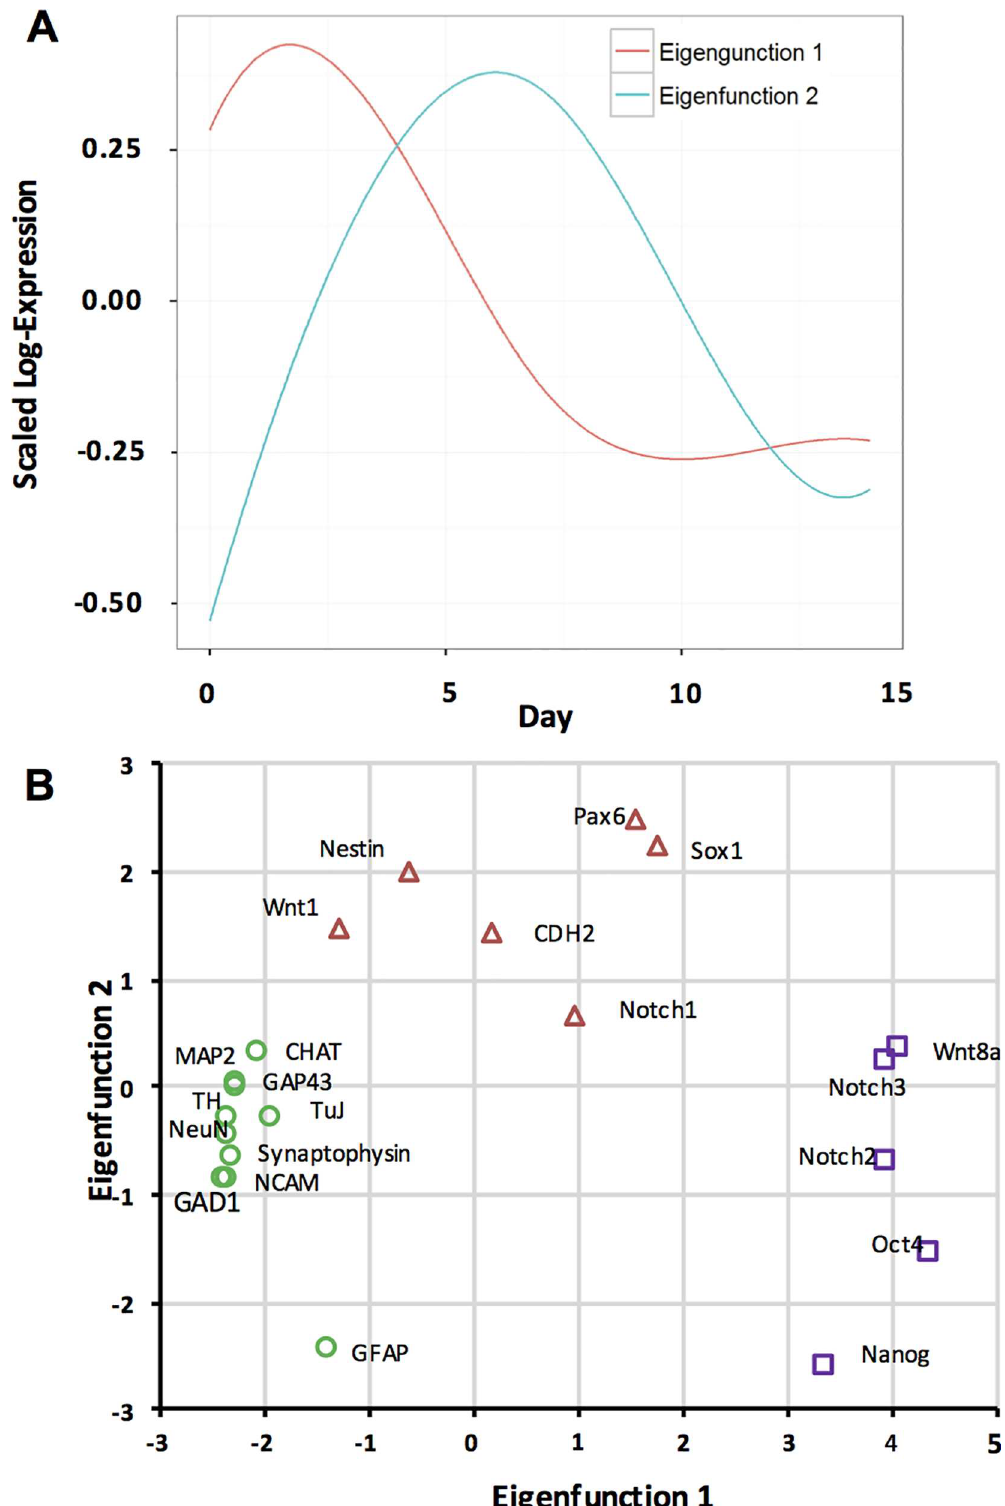
Fig 3. Functional principal component analysis of gene expression. (A) Eigenfunctions (EF) of gene expressionare shown over time. The trajectory of each gene may be approximated by an additivecombination